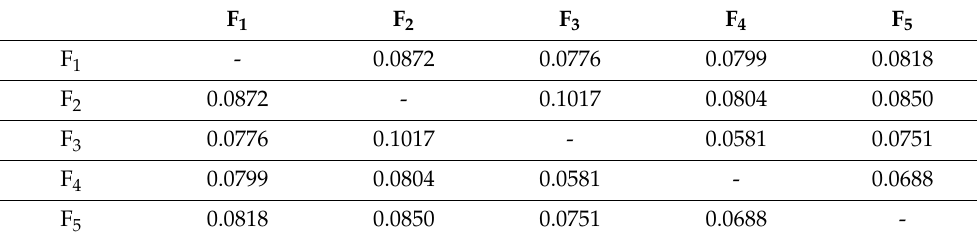
Table 12. Pythagorean fuzzy composite distance